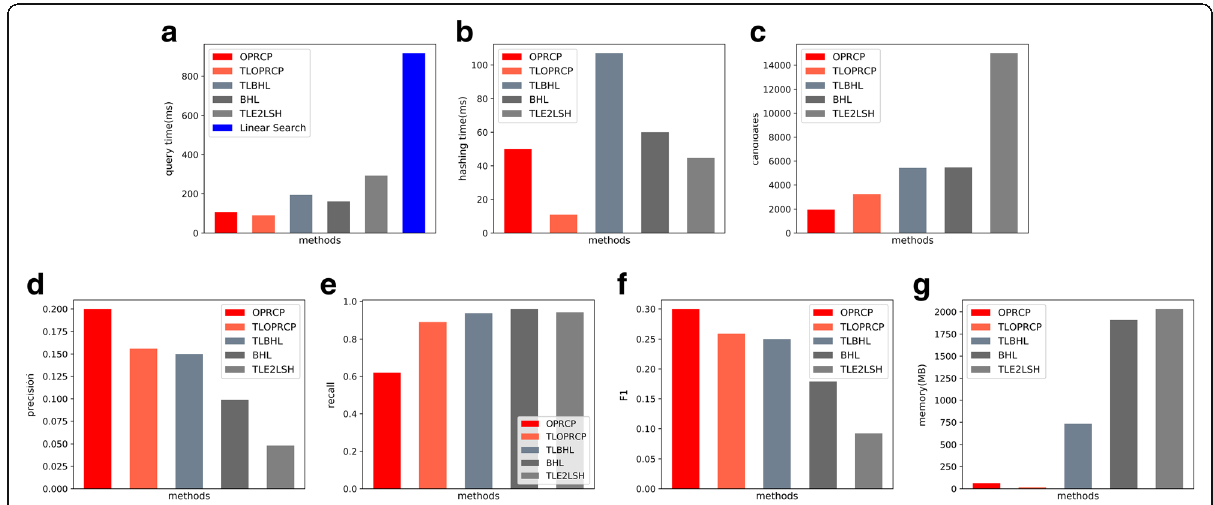
Fig. 9 Comparison of algorithms in MNIST dataset. a k versus the find nearest time between different methods. b k versus the hashing time between different methods. c k versus the rate of candidates between different methods. d k versus the precision between different methods. e k versus the recall between different methods. f k versus the value of F1between different methods. g k versus the cost of memory between different